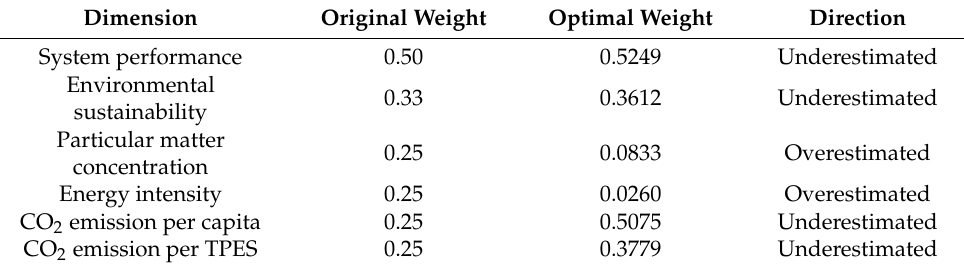
Table 2. Original and optimised weight for chosen ETI